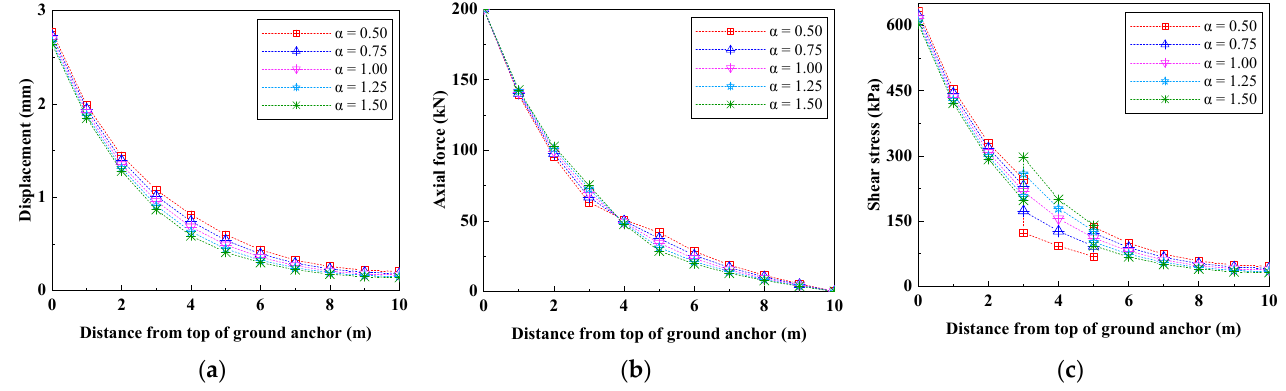
Figure 13. Effect of shear modulus change of Stratum-2 on mechanical behavior of ground anchor. (Case 2: condition 4) ( a ) displacement distribution curve; ( b ) axial force distribution curve; ( c ) shear stress distribution curve.